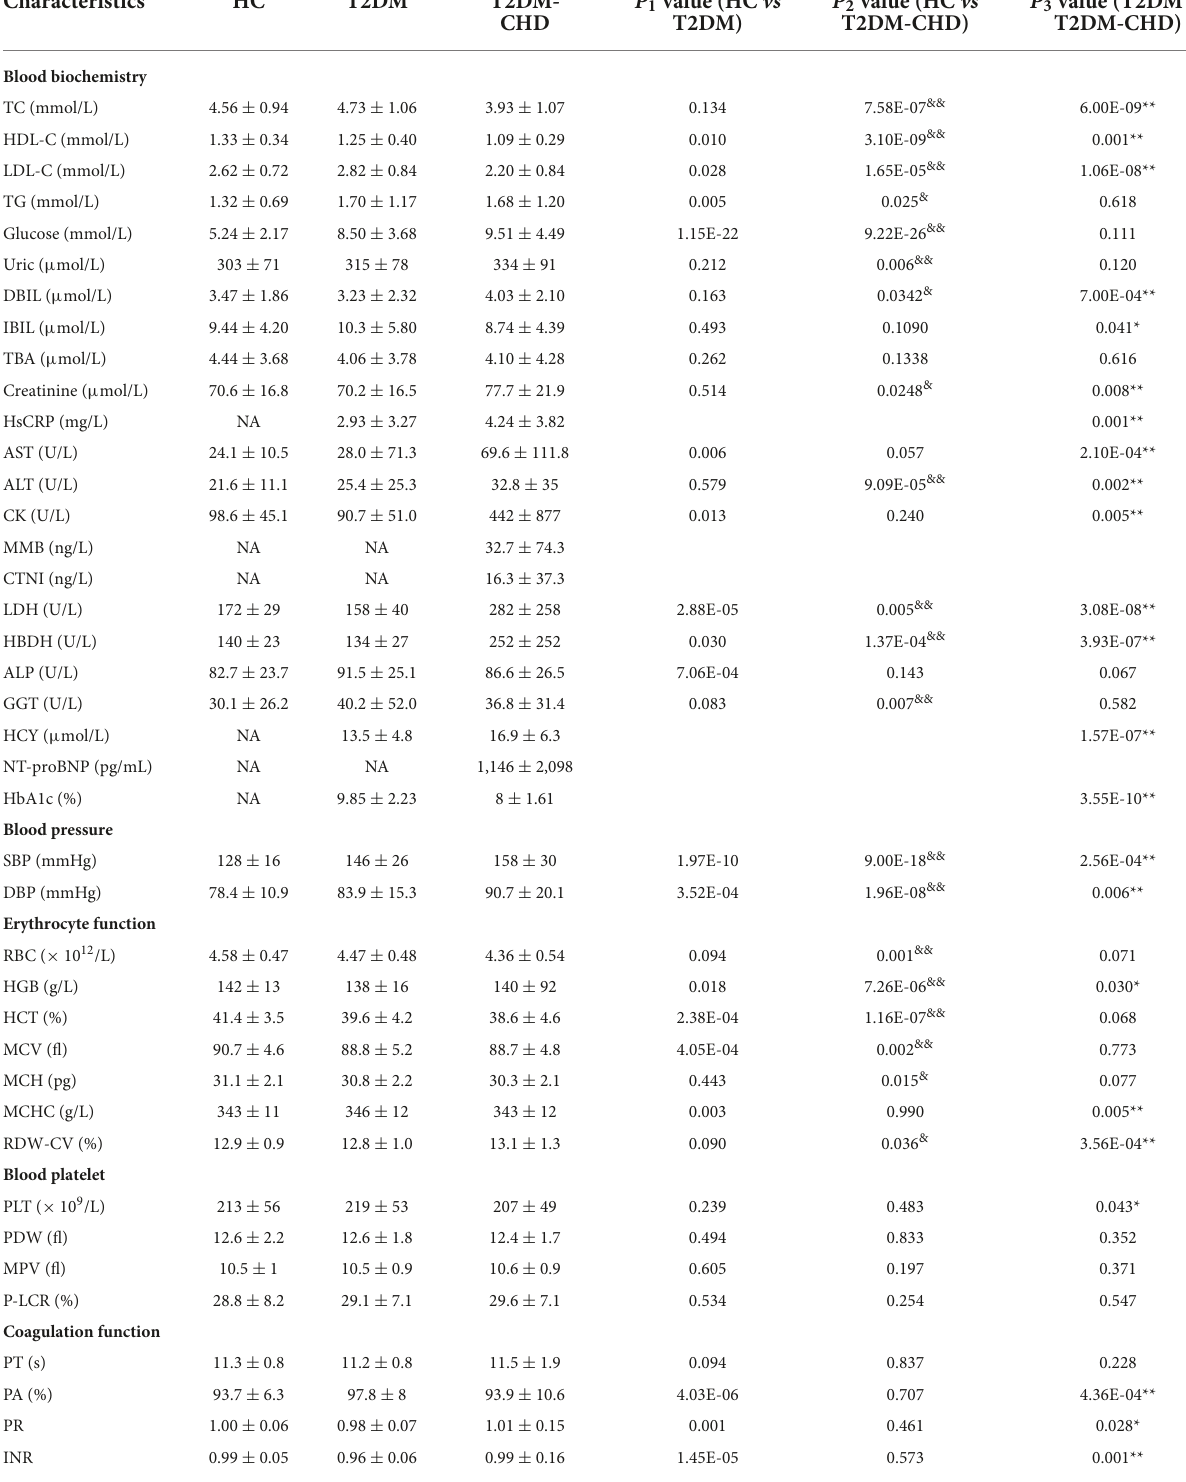
TABLE 2 Results of clinical laboratory